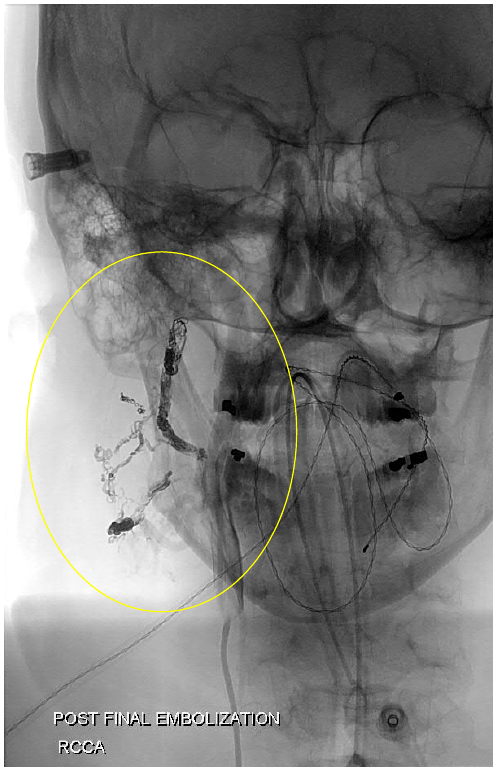
Figure 6. Coil embolization of a neck AVM. Coils were placed in the feeder arteries to this nidus that branched mainly from the right occipital artery.